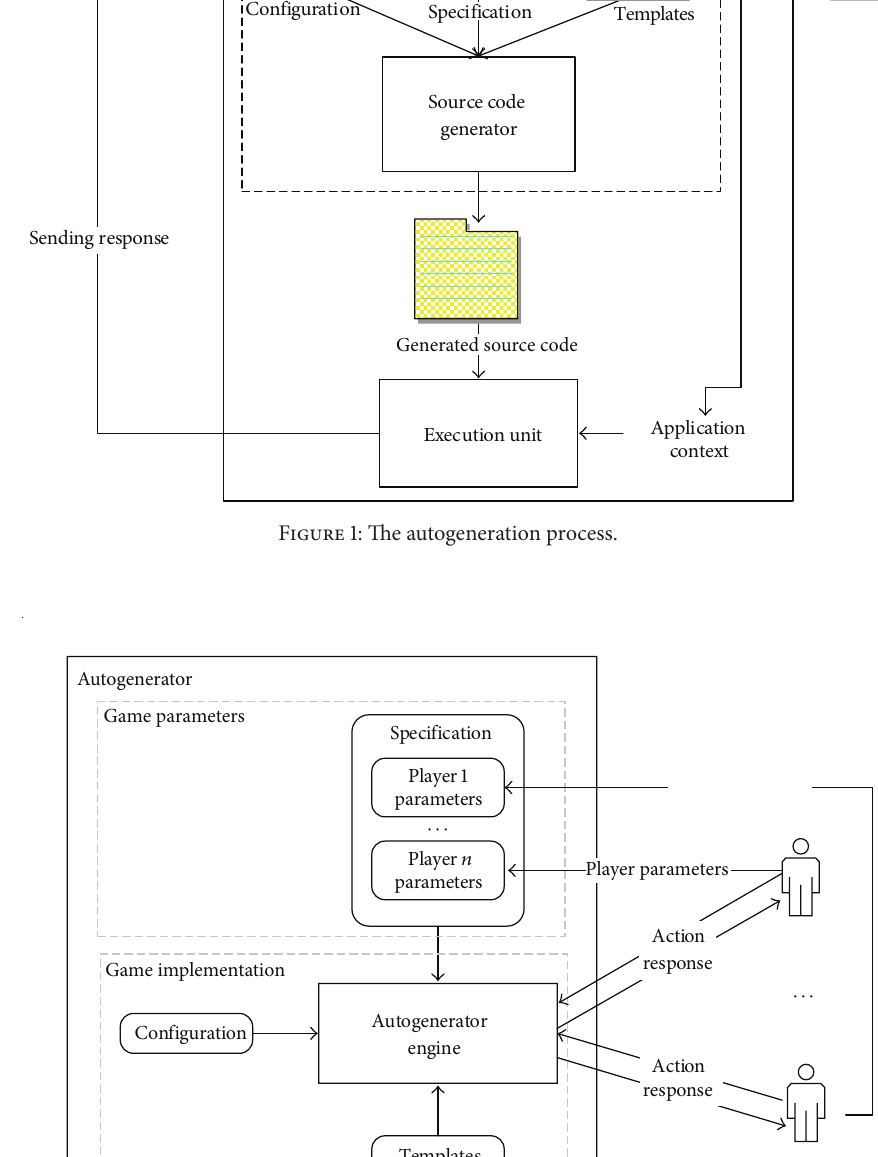
Figure 2: Model of using autogenerator in strategic